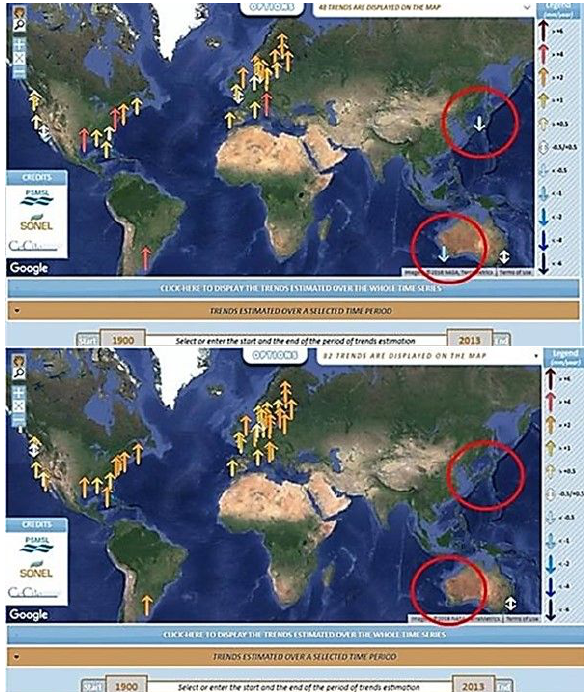
Figure 4: Absolute sea level rates of rise (relative sea-level rate of rise from tide gauge, absolute vertical land velocity from satellite GPS) in the world tide gauges with theoretically same data 1900 to 2013 before and after Fremantle was eliminated from the database of absolute sea level rises. Images modified from SONEL, [20]. The top is the “ before ” image, from [28]. The bottom, is the “ after ” image, downloaded 6 June 2018. Images modified after [27].